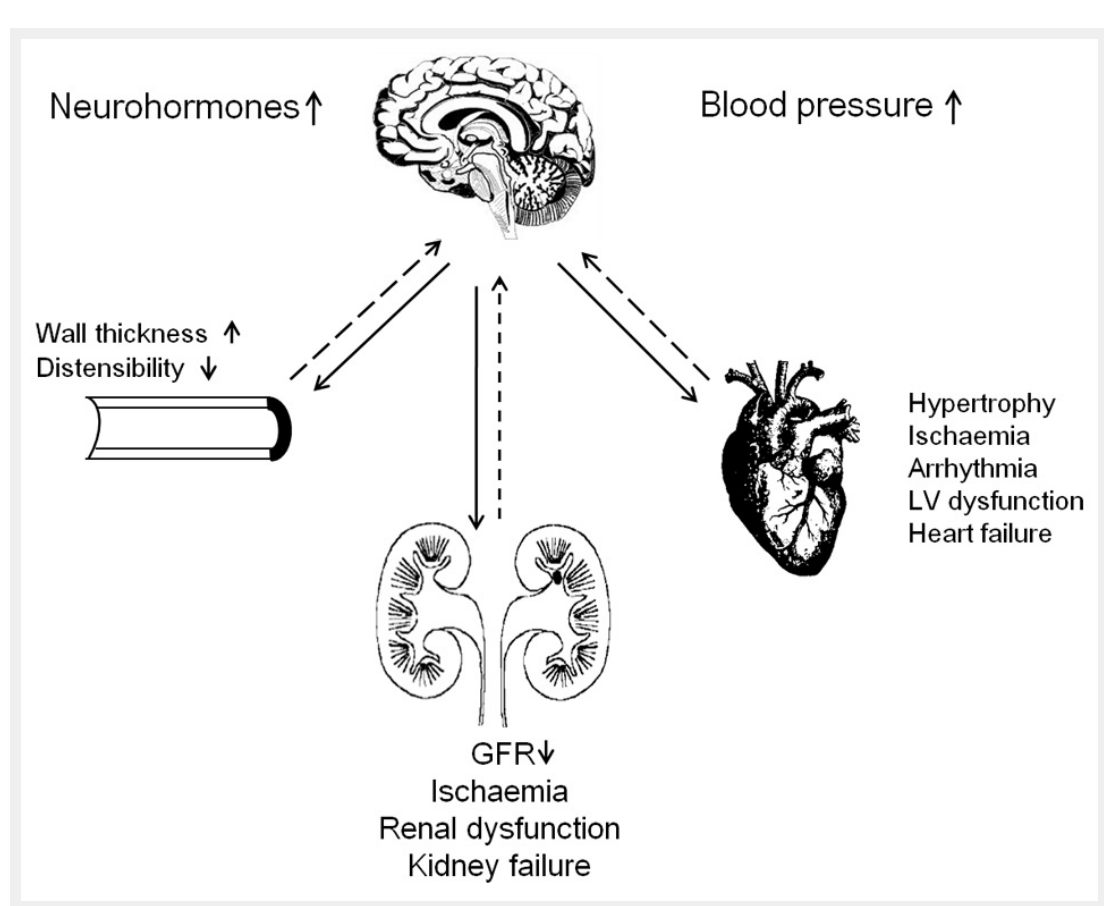
Figure 1 Effect of sympathetic afferent and efferent nerves. Solid and dashed lines represent afferent and efferent nerve traffic, respectively. Abbreviations: LV, left ventricular; GFR, glomerular filtration